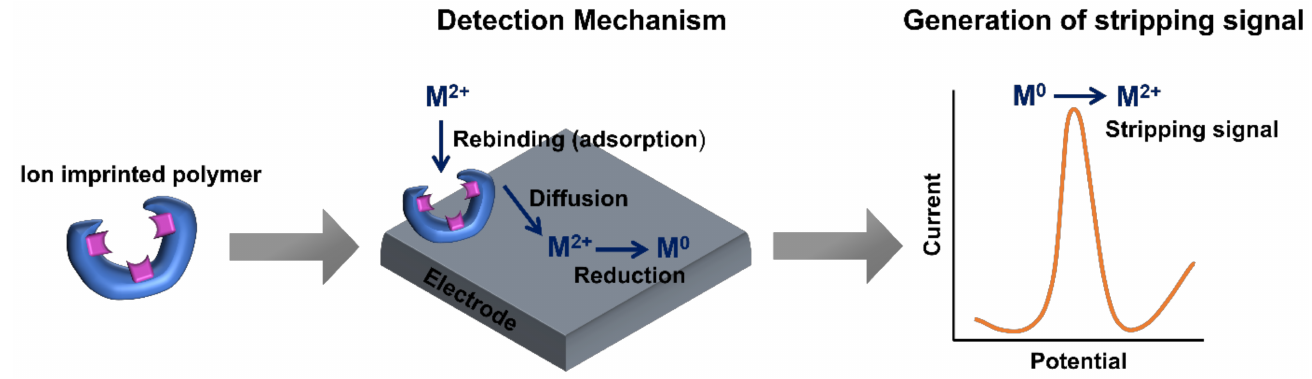
Figure 4. Schematic representation of the detection mechanism of electrochemical IIP-based